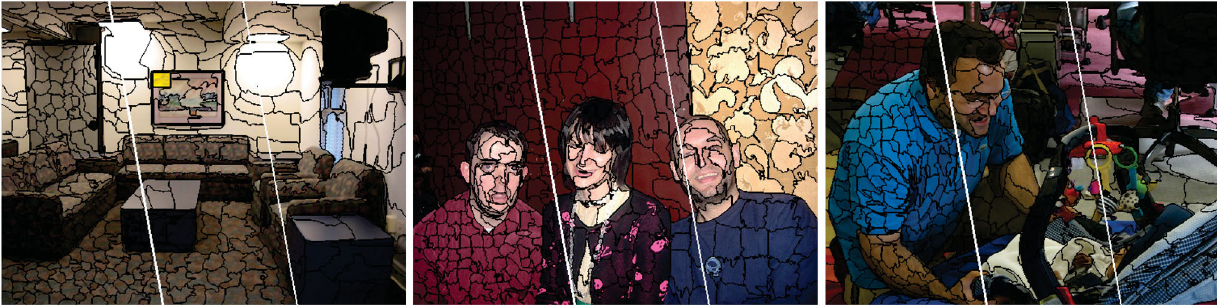
Fig. 13 Images from the BSDS dataset segmented by our approach with m = 20 and the number of superpixels set to 1000, 400, and 200, respectively. The resulting superpixels follow region boundaries very well.